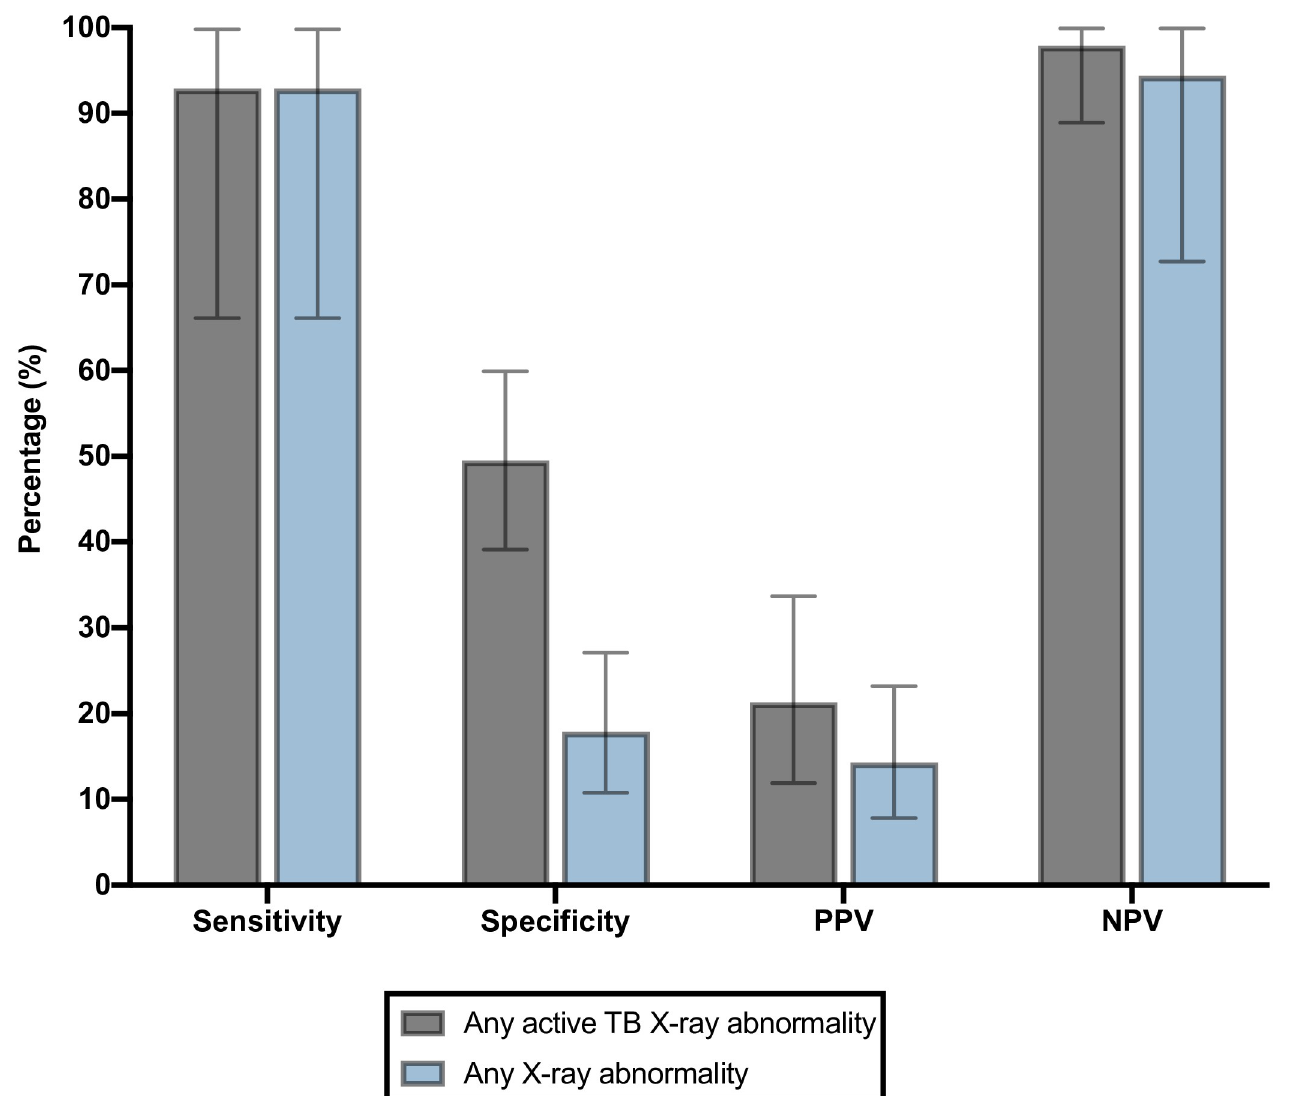
Fig 2. Diagnostic accuracy of chest radiograph findings for active TB disease among presumptive TB patients with a prior history of TB disease (n = 109). Bars refer to 95% confidence intervals. Abbreviations: PPV = positive predictive; NPV = negative predictive value.